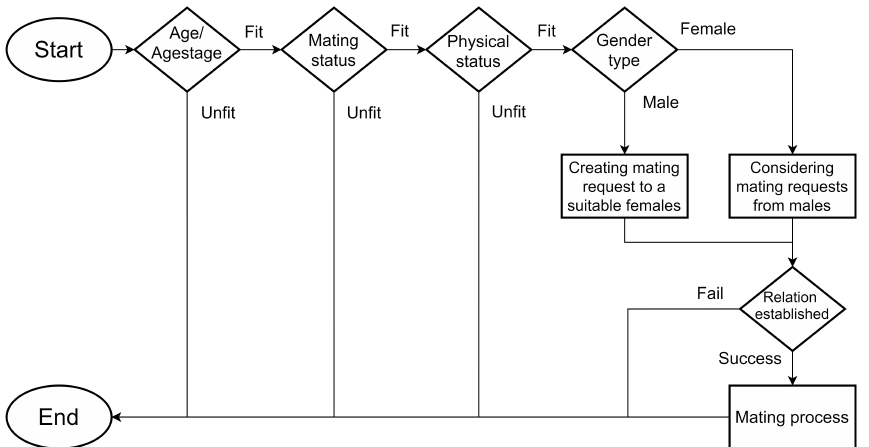
Figure 8. A simplified representation of the animal’s mating system. The Start and End ellipses represent the boundaries of the algorithm logic. Rectangles represent the different processes, and diamond shapes represent the requirements and